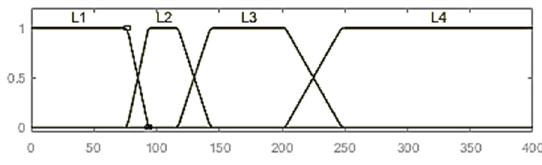
Figure 8. Input membership functions for DPM interpretation results.